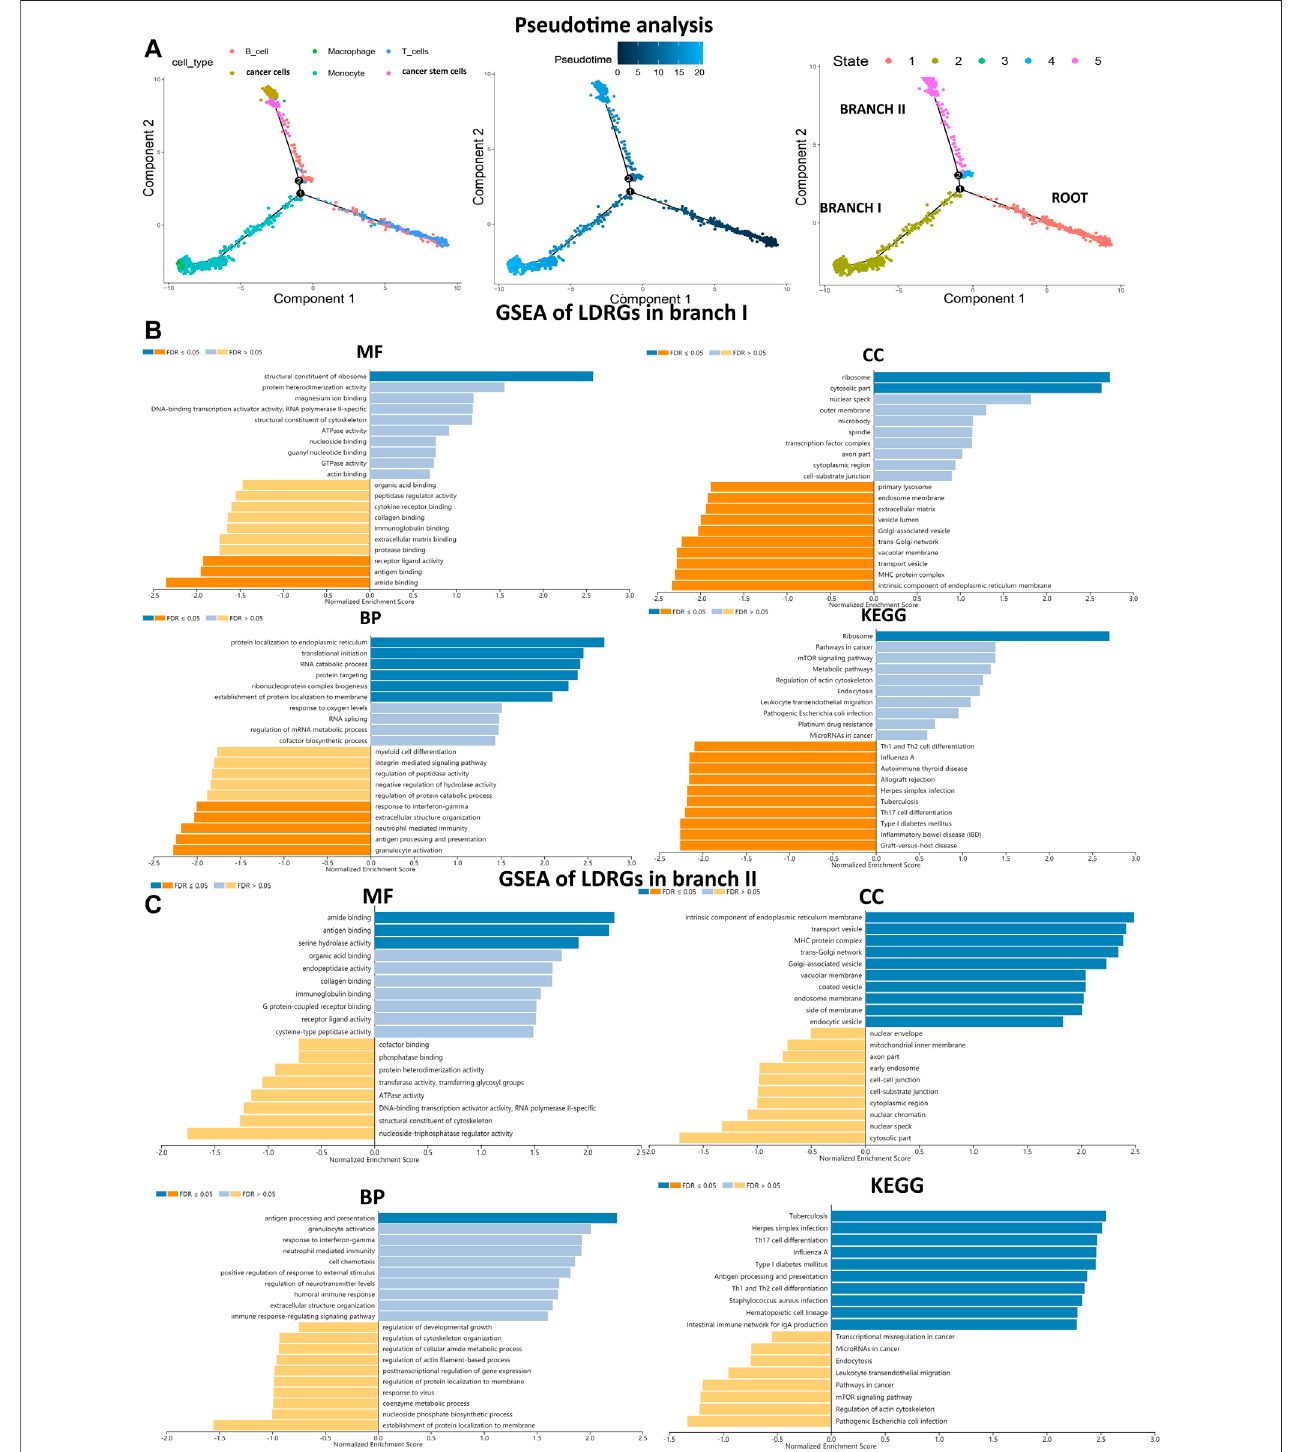
FIGURE 2 | Trajectory analysis identi fi ed two branches, and GSEA analyzed biological functions. (A) Pseudo-time analysis reveals two LUAD branches with different evolution trajectories. (B,C) MF, CC, BP and KEGG for branches I and II LDRGs were conducted to assess related biological functions. An FDR < 0.05 was considered statistically signi fi cant. Blue represented pathway activation, and orange represented pathway inhibition.